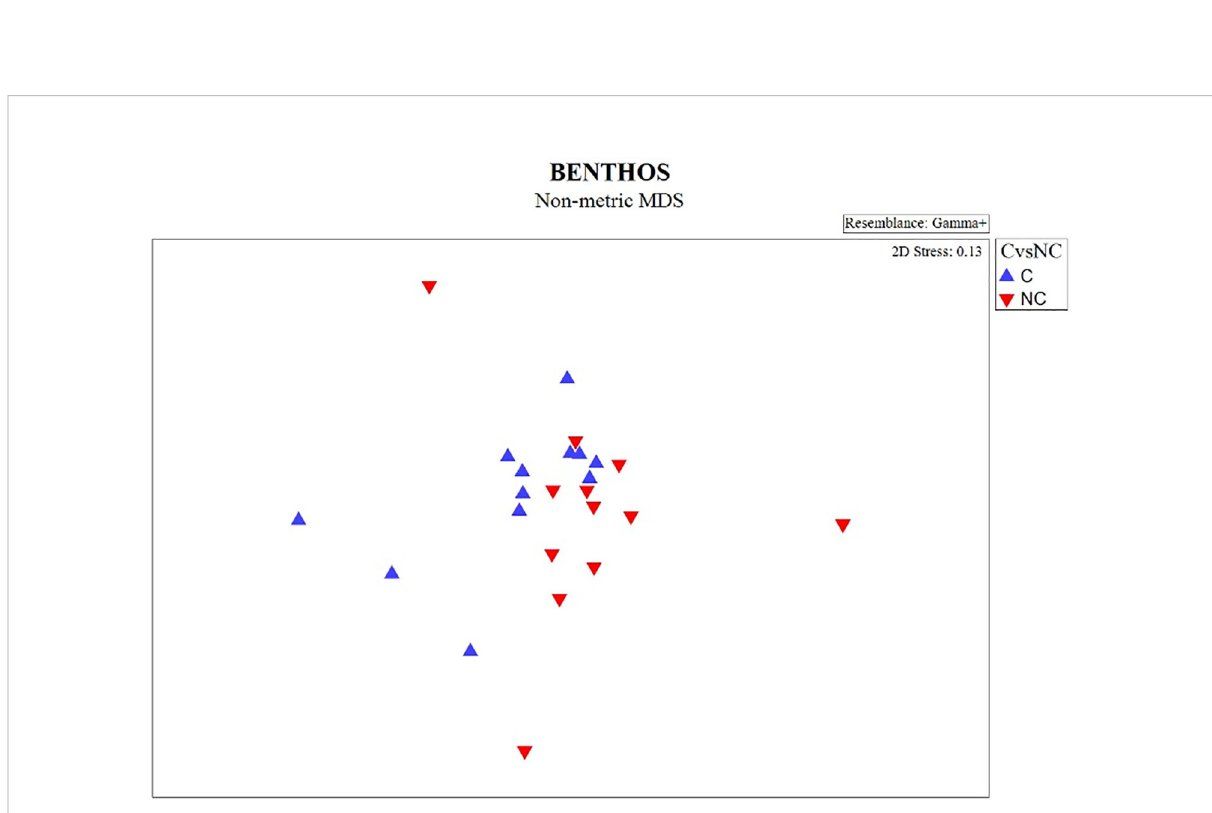
FIGURE 8 nMDS plot showing the gamma+ resemblance of benthic composition between canyon (C) and non-canyon (NC)